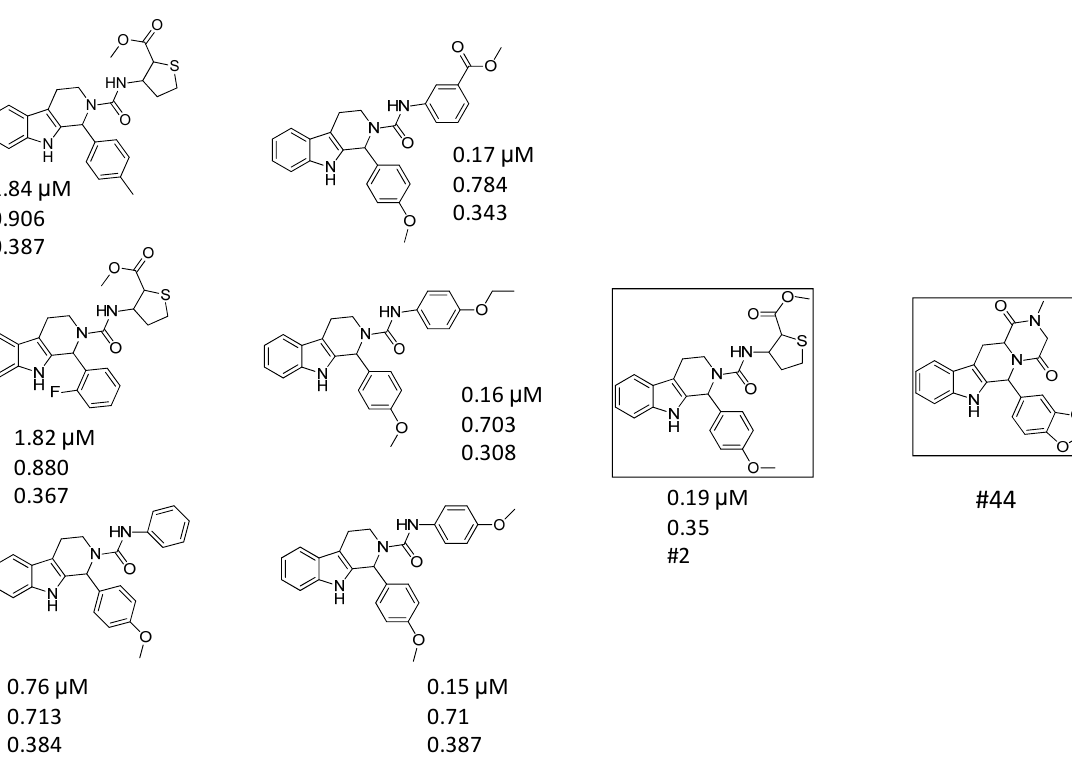
Figure 3. Hits derived from #44 seed with the T3D similarities to the first round hit and seed (reference compound)—Series #2.